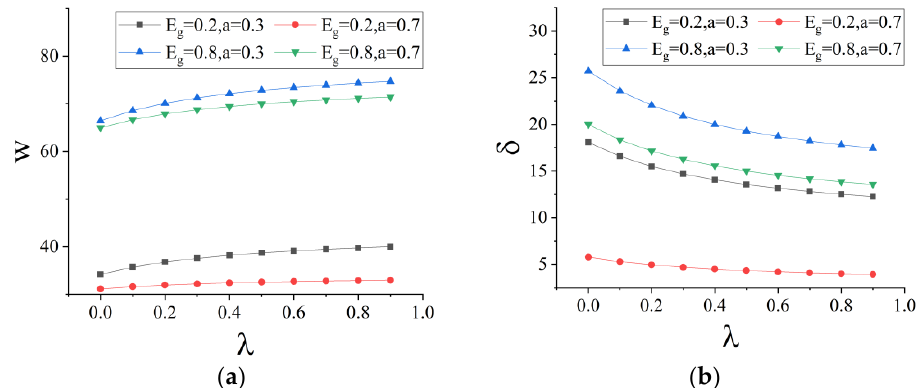
Figure 2. The impact of fairness concerns of manufacturer on the wholesale price and profit per unit of product. ( a ) The impact of fairness concerns of manufacturer on the wholesale price; ( b ) The impact of fairness concerns of manufacturer on profit per unit of product.